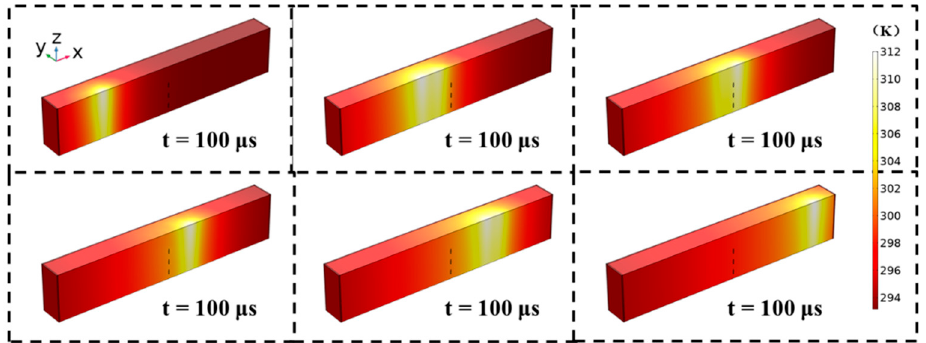
Figure 4. Moving laser heating material (10 W; 1000 mm/s).